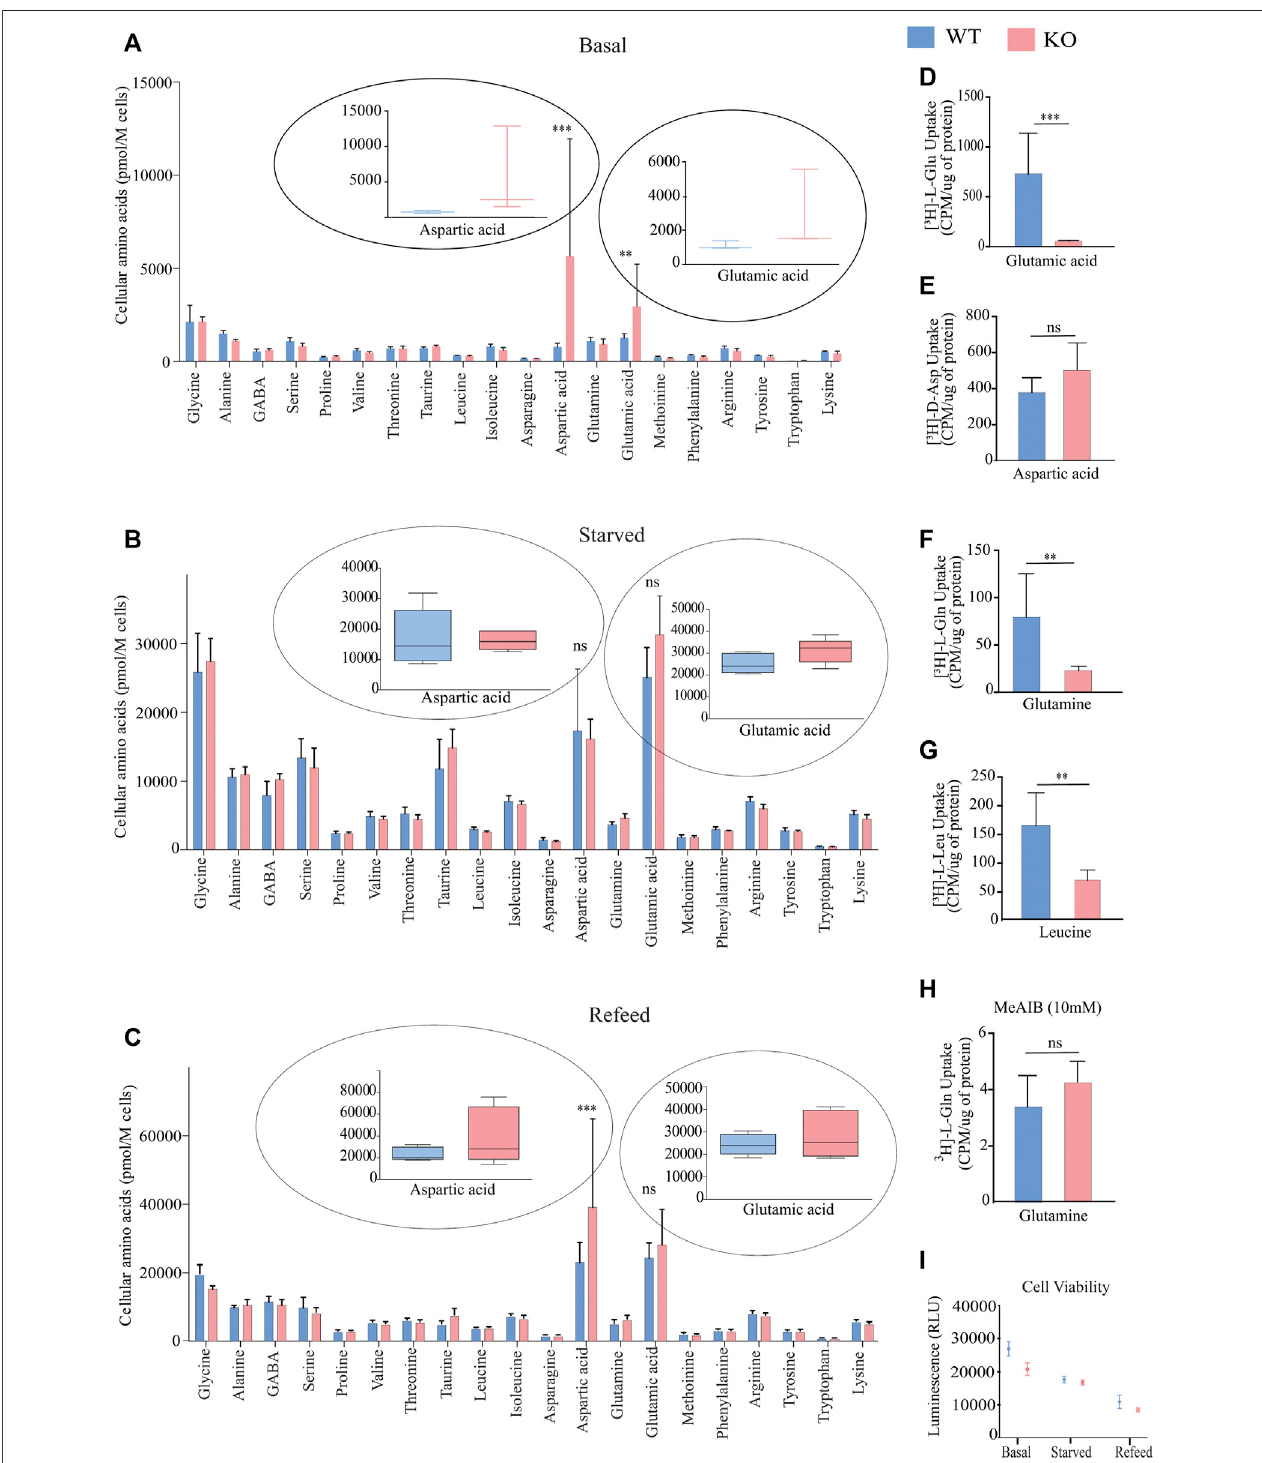
FIGURE 1 | Measurement of intracellular amino acids and uptake in primary cortex cells de fi cient of SLC38A10 compared to WT using LC-MS/MS at basal, starved, and Refed conditions. (A) Intracellular amino acid levels in primary cortical neuronal cells (WT and KO) cultured in complete media for ten days. (B) The amino acidcontentinWT andKO PCCsstarved inaminoacidsfor2 h afterB27deprivation overnight. (C) WTand KOPCCs refedwithmedium containingaminoacidsfor1 h after 2-h starvation of amino acids. (A – C) After culturing in different conditions, cells were washed, and the absolute levels of intracellular amino acids were quanti fi ed using LC/MS/MS. Data represent mean ± SD and n = 6. (D – H) Comparison of basal amino acid uptake in WT and KO primary cortical culture of 3H labeled